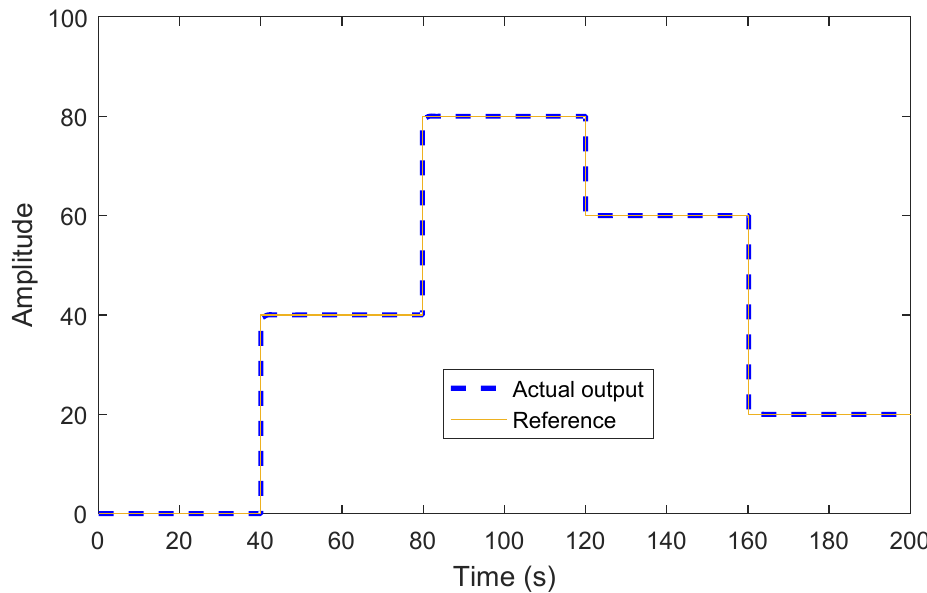
Figure 9. Response of SLSSO-based controller for variable step input for loop II.